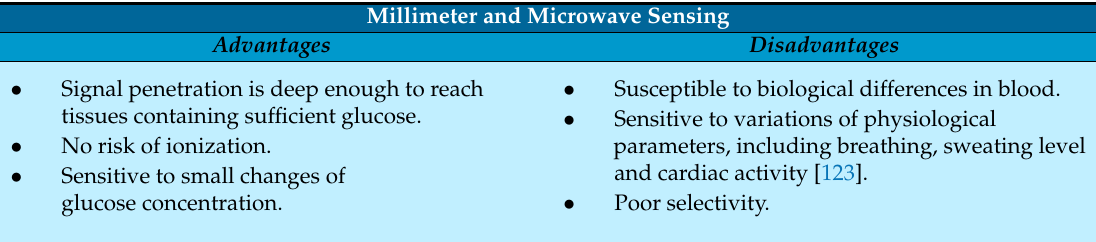
Table 17. Advantages and disadvantages of millimeter and microwave sensing.